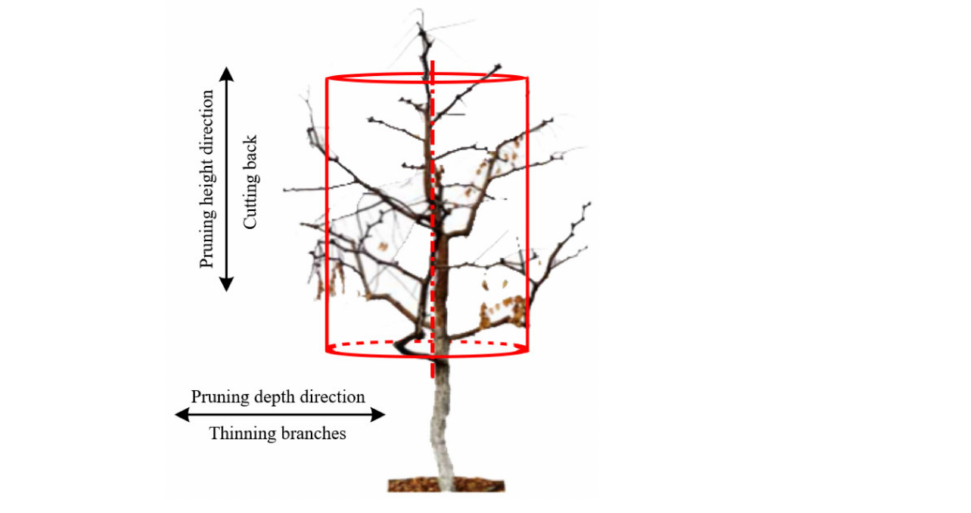
Figure 10. The schematic diagram for the agronomic analysis of jujube tree pruning.